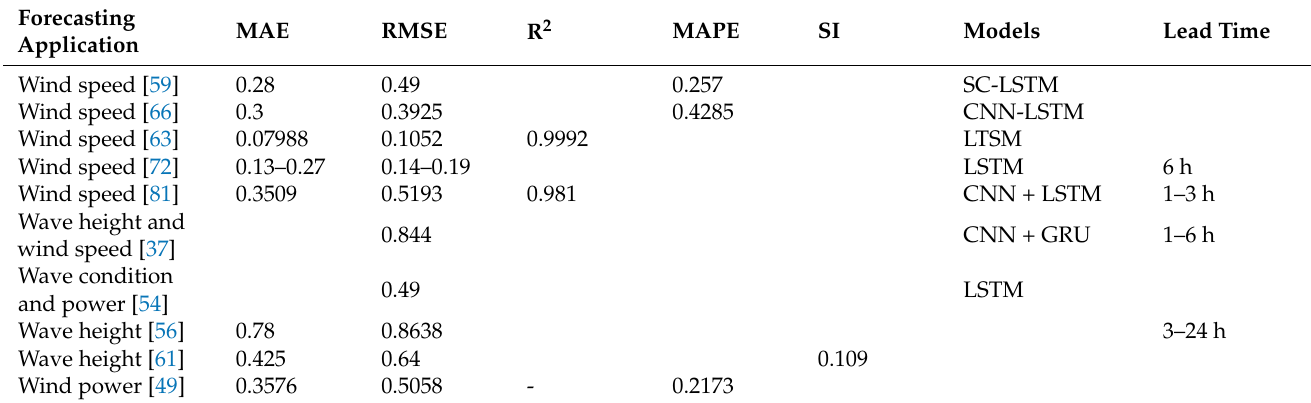
Table 7. Summarized Performance of Different Deep Learning